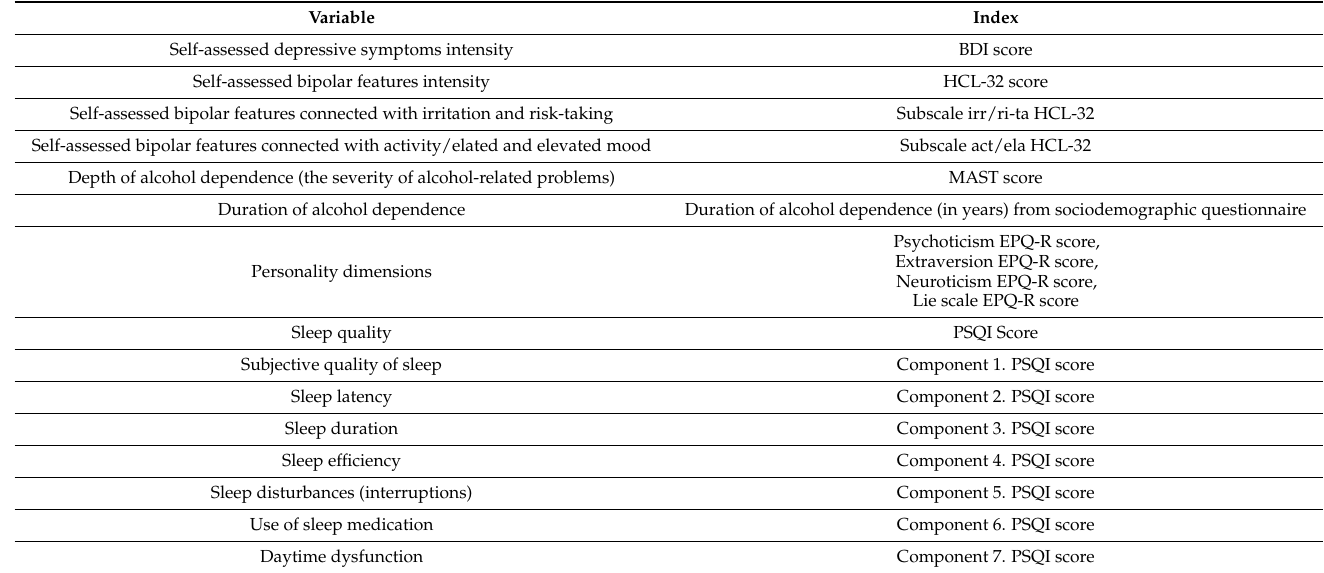
Table 2. Presentation of dependent and independent variables included in the analysis, together with their